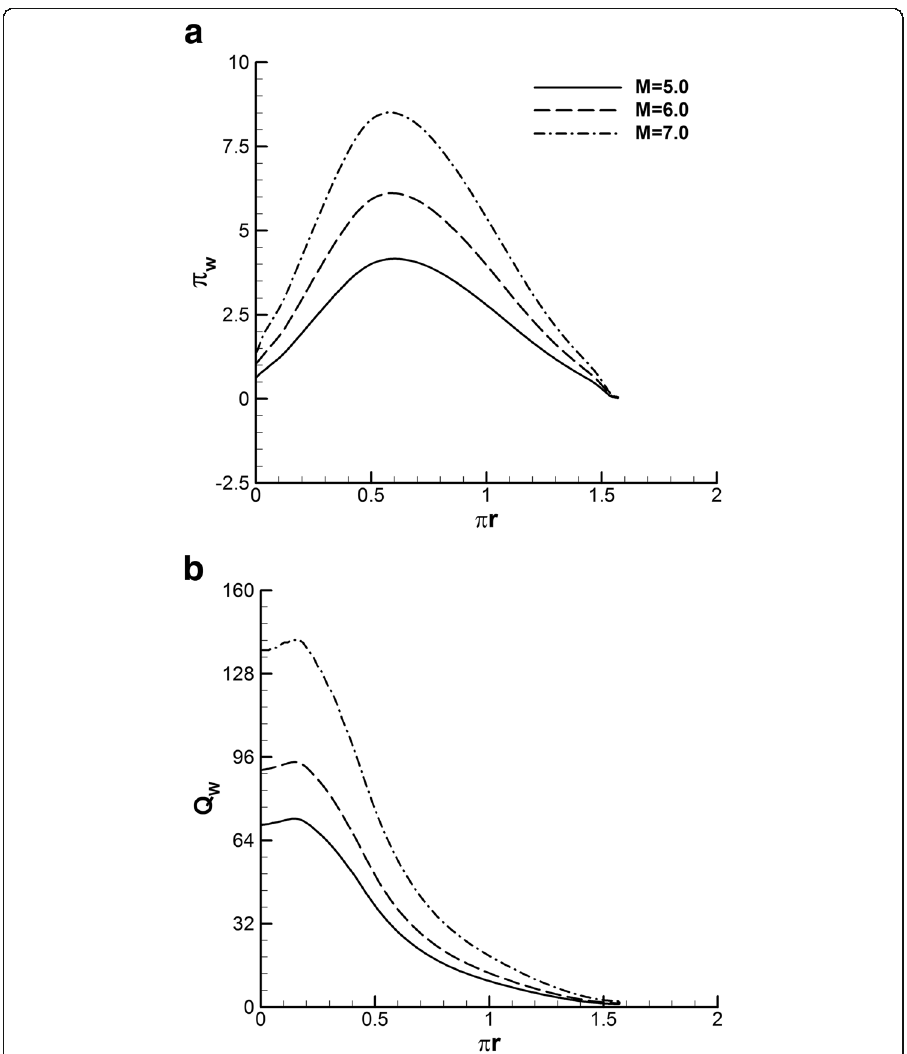
Fig. 13 Comparison of normalized quantities measured on the surface of the circular cylinder for different Mach numbers (5, 6, and 7) at Kn = 0.005: a shear stress, and b heat